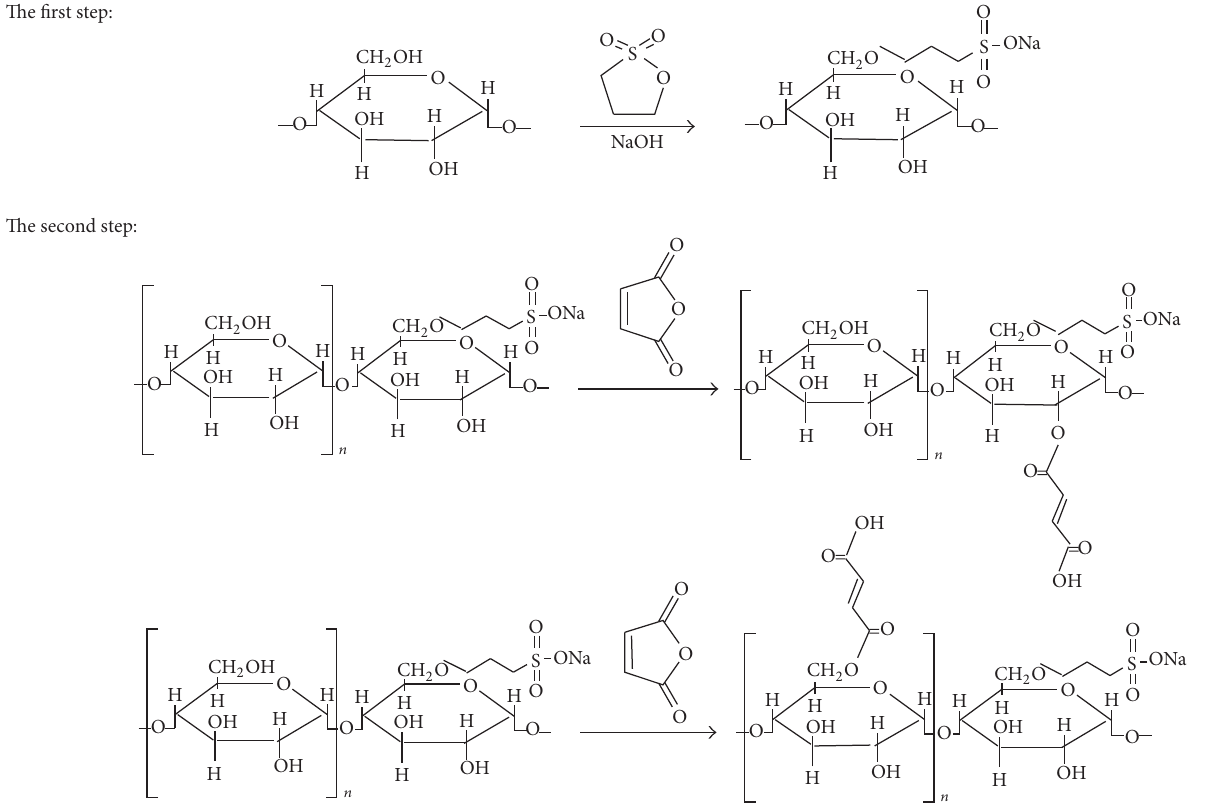
Scheme 1: Preparation process of